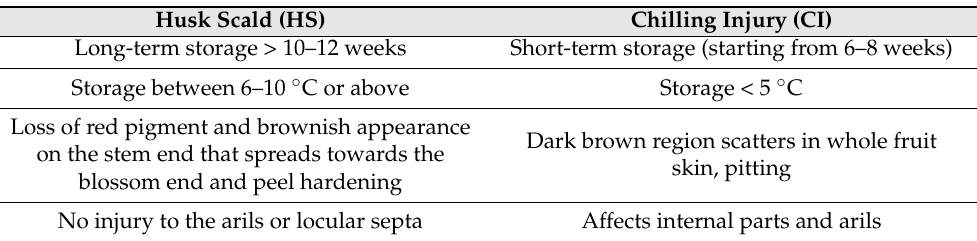
Table 1. Difference between husk scald and chilling injury in pomegranate fruit during storage. Husk Scald (HS) Chilling Injury (CI) Long-term storage > 10–12